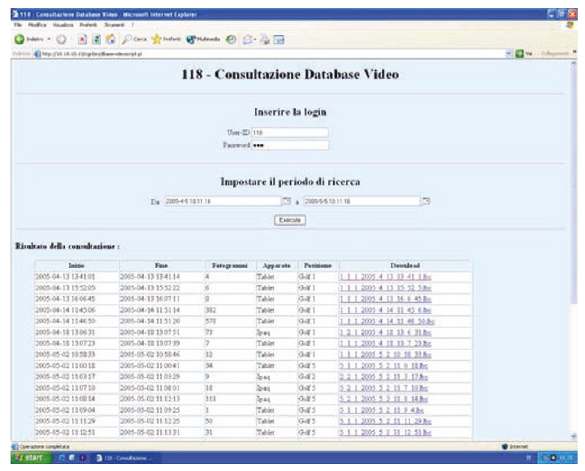
Figure 7: Simple web browser interface to access the multimedia